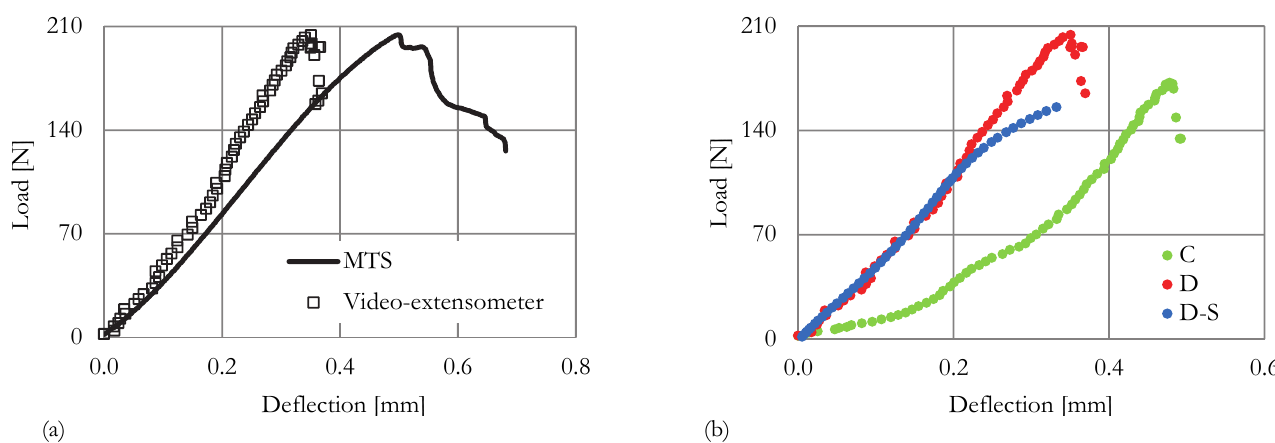
Figure 7: (a) The load-deflection curves obtained by the video-extensometer and the loading frame for a typical diabetic femur; (b) typical load-deflection curves for the three animal groups of the present study.